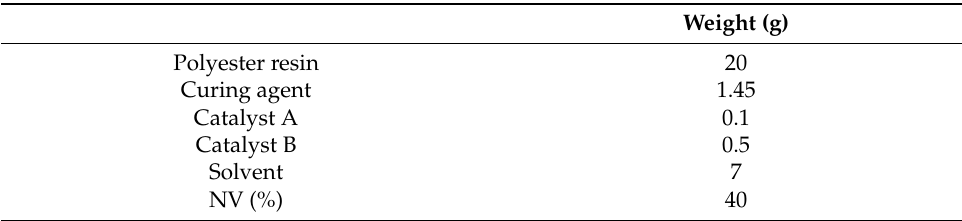
Table 2. Formulation of polyester clear